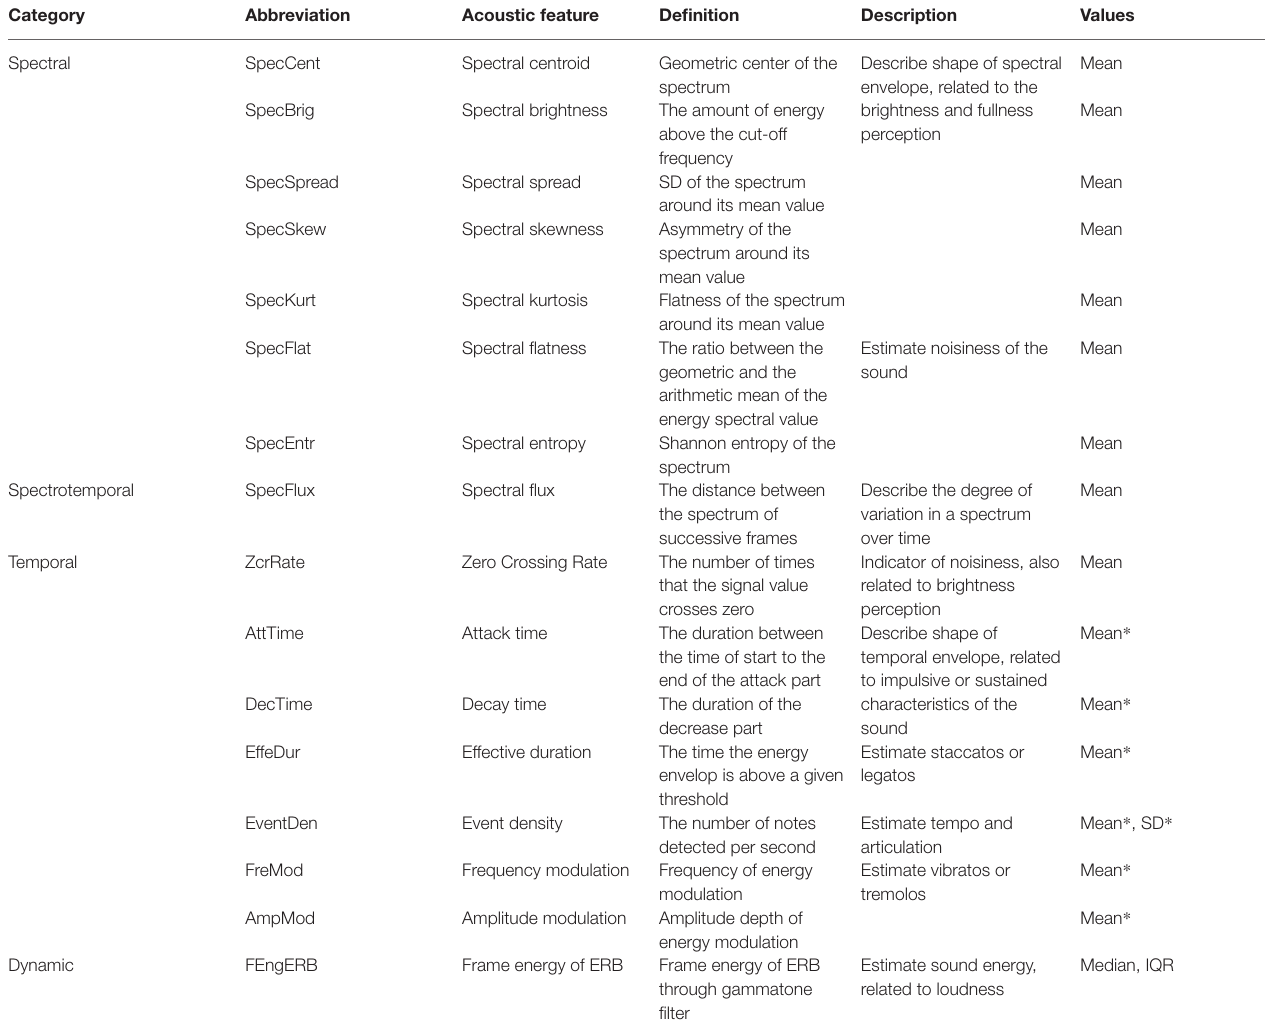
TABLE 2 | Acoustic features related with timbre and performing